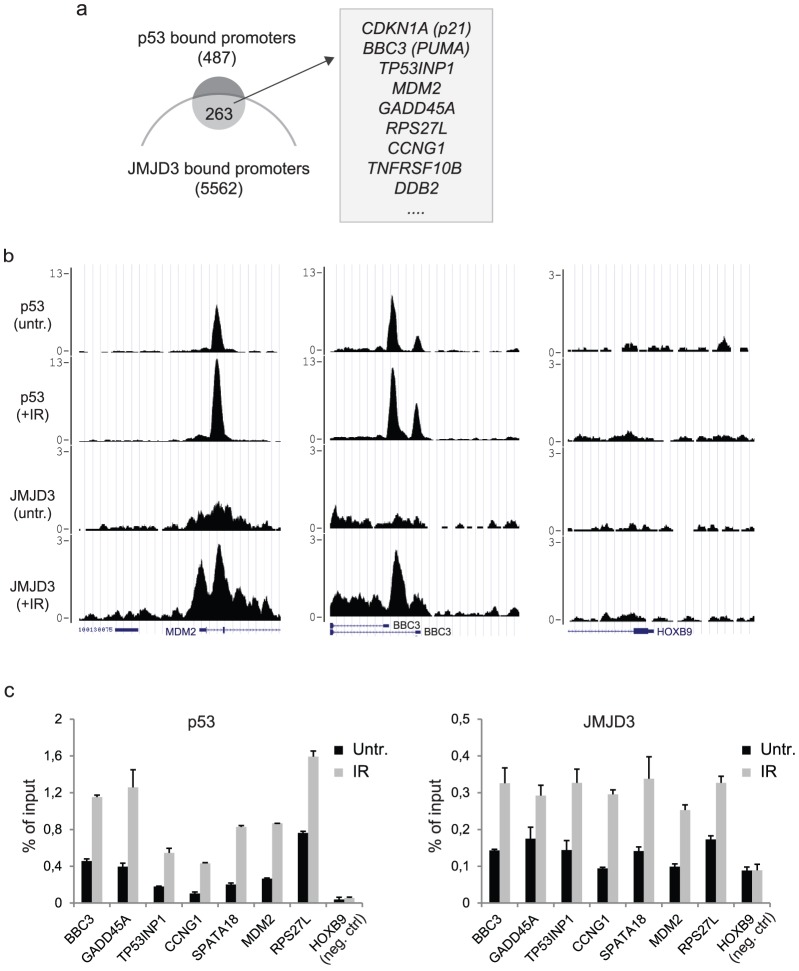
IR responsive recruitment of JMJD3 and p53 to promoter regions.a, Venn diagram demonstrating significant (p<10−8) overlap between JMJD3 and p53 target genes in the IR treated BJ cells. At least 263 genes were found to be bound by both JMJD3 and p53 in the promoter regions, which included several well-known p53 target genes such as CDKN1A, BBC3, TP53INP1, MDM2, GADD45A, RPS27L, CCNG1, TNFRSF10B, and DDB2.
b, Examples of p53 (before and after IR treatment) and JMJD3 (before and after IR treatment) ChIP-seq tracks at BBC3, MDM2, TP53INP1, RPS27L and HOXB9 (negative control). y-axis of binding profiles denotes number of sequence tag reads. c, The corresponding p53 and JMJD3 ChIP-qPCR validations at the TSS of the genes listed above.